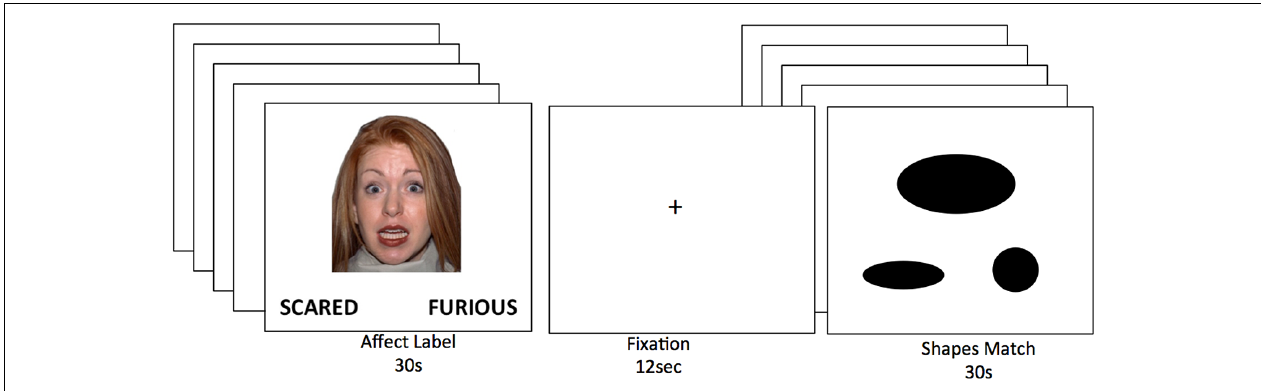
FIGURE 1 |The affect labeling task. Conditions included two blocks of affect labeling and two blocks of shapes matching, separated by 12 s of fixation.